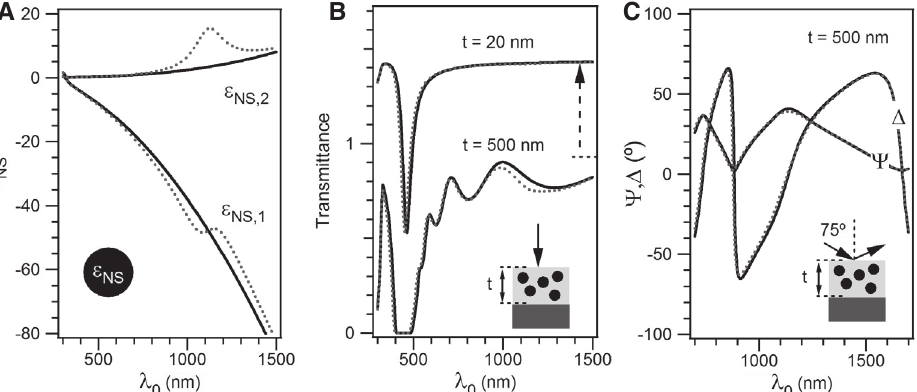
Figure 6 Determining the dielectric function of plasmonic NPs – intrinsic limitation of optical measurements. (A) Real and imaginary part of the dielectric function ε of fictitious NPs, with a Drude-like behavior (dark full lines) or with a Drude-like component plus a Lorentz NS peak, centered at 1120 nm (gray dotted lines). (B) Transmittance spectra of effective media (deposited on a SiO substrate), calculated 2 in the Maxwell-Garnett approximation assuming spherical NPs with the dielectric functions ε defined in (A) embedded in a transparent NS = 2.72) with a 10% volume fraction. Two thicknesses t (20 nm and 500 nm) have been chosen for the effective medium. Plasmon matrix ( ε m resonance is observed around 450 nm. (C) Calculated ellipsometry spectra (75 ° incidence) for the effective media defined in (B) (deposited on Si). The Lorentz peak contribution to ε affects in an extremely weak way T, Ψ and Δ in the NIR range, so that a clear graphical evidence NS of its influence in this range can be noticed only in the T spectrum of the 500-nm-thick